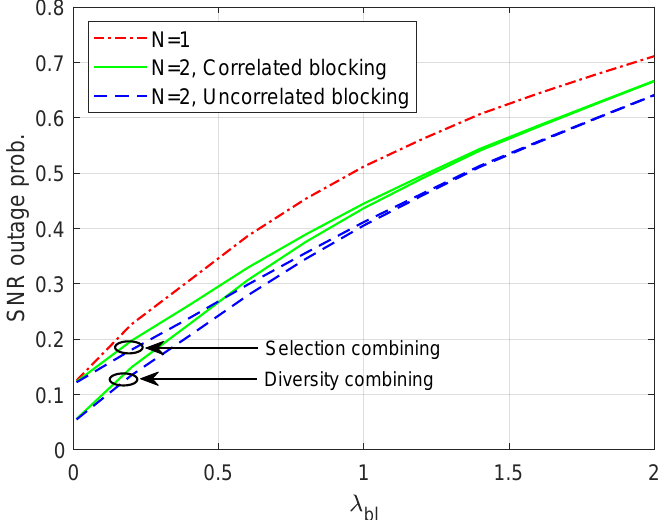
Figure 8. The SNR outage probability at threshold β = 10 dB with respect to λ bl when N = 1,2, with and without considering blockage correlation at fixed values of blockage density λ bs = 0.3 and blockage width W =